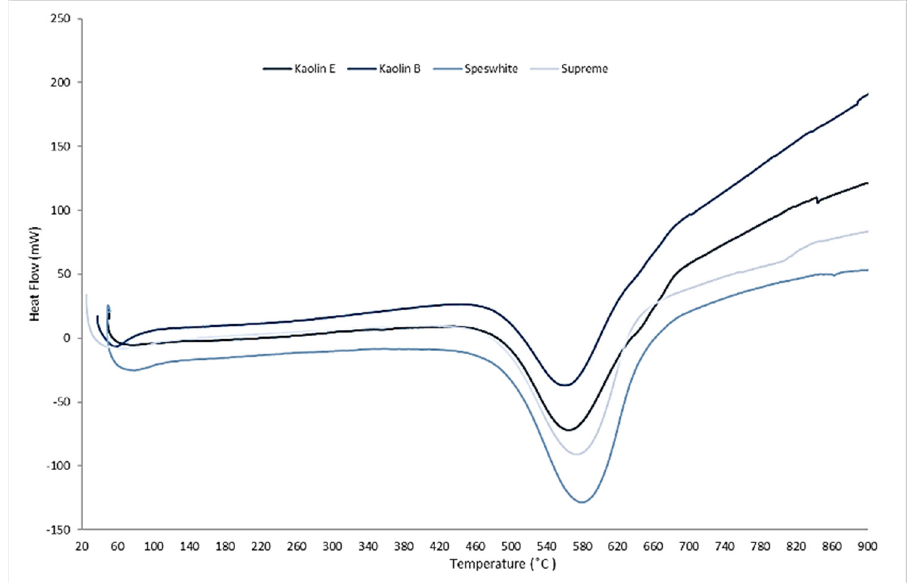
Figure 9. DTA curves of raw materials.